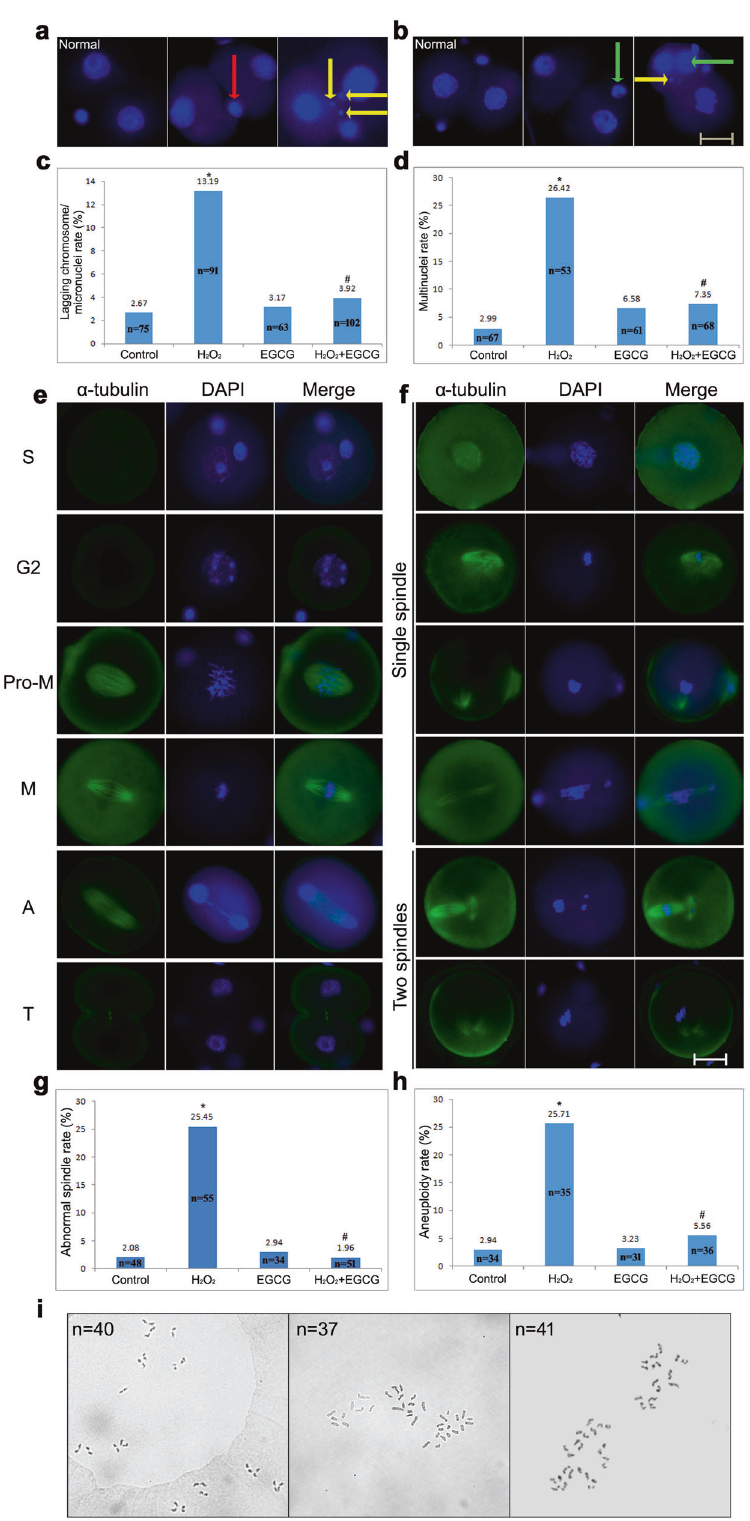
particular, H 2 O 2 treatment increased the expression of proteins acting as structural constituents of the ribosome and involved in rRNA binding. In addition, 61.2% (90/147) of the downregulated proteins were assigned to catalytic activity; in particular, H 2 O 2 treatment decreased the expression of proteins involved